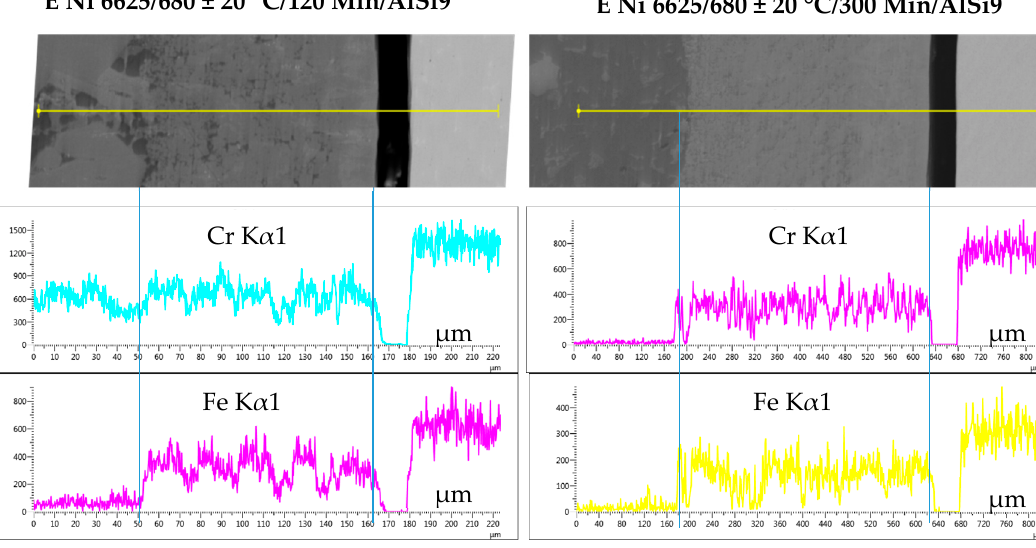
Figure 17. EDX line microanalysis.